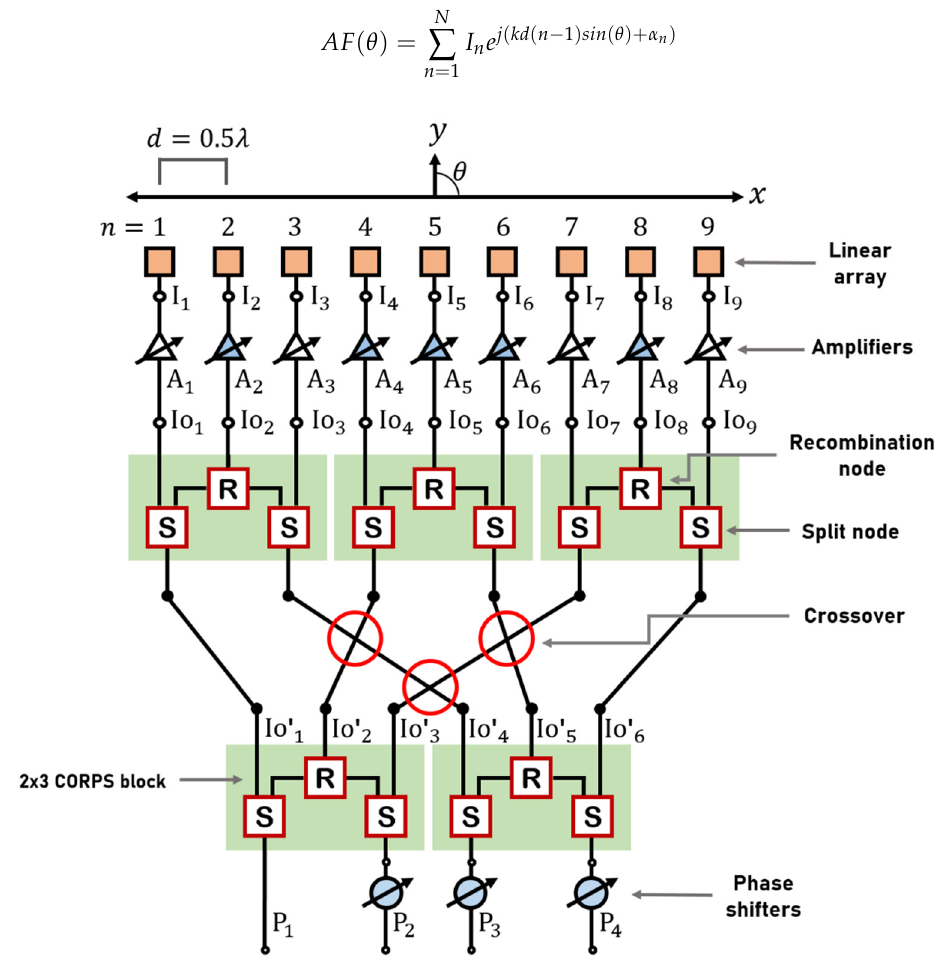
Figure 3. Proposed design scheme for a linear antenna array of 9 elements based on 2 × 3 CORPS networks and crossovers.